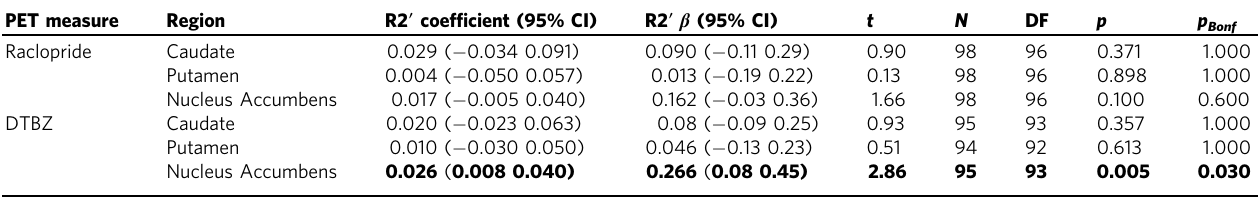
participants with available data for either measure at either time point and use full information maximum likelihood to impute missing data ( β = 0.434, z = 2.37 p = 0.018; complete cases β = 0.441, z = 2.21, p = 0.027).